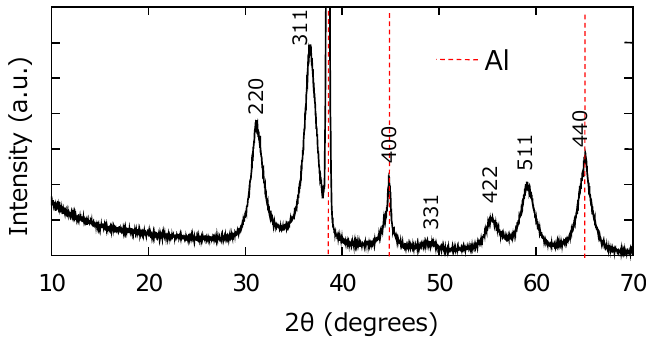
Figure 3. XRD patterns of the ZnAl 2 O 4 /Al sample. The peaks of ZnAl 2 O 4 were all indexed in this figure. On the other hand, the peak positions of Al were only indicated by a red dash line. The 400 and 440 peaks were overlapped with the small Al peaks.